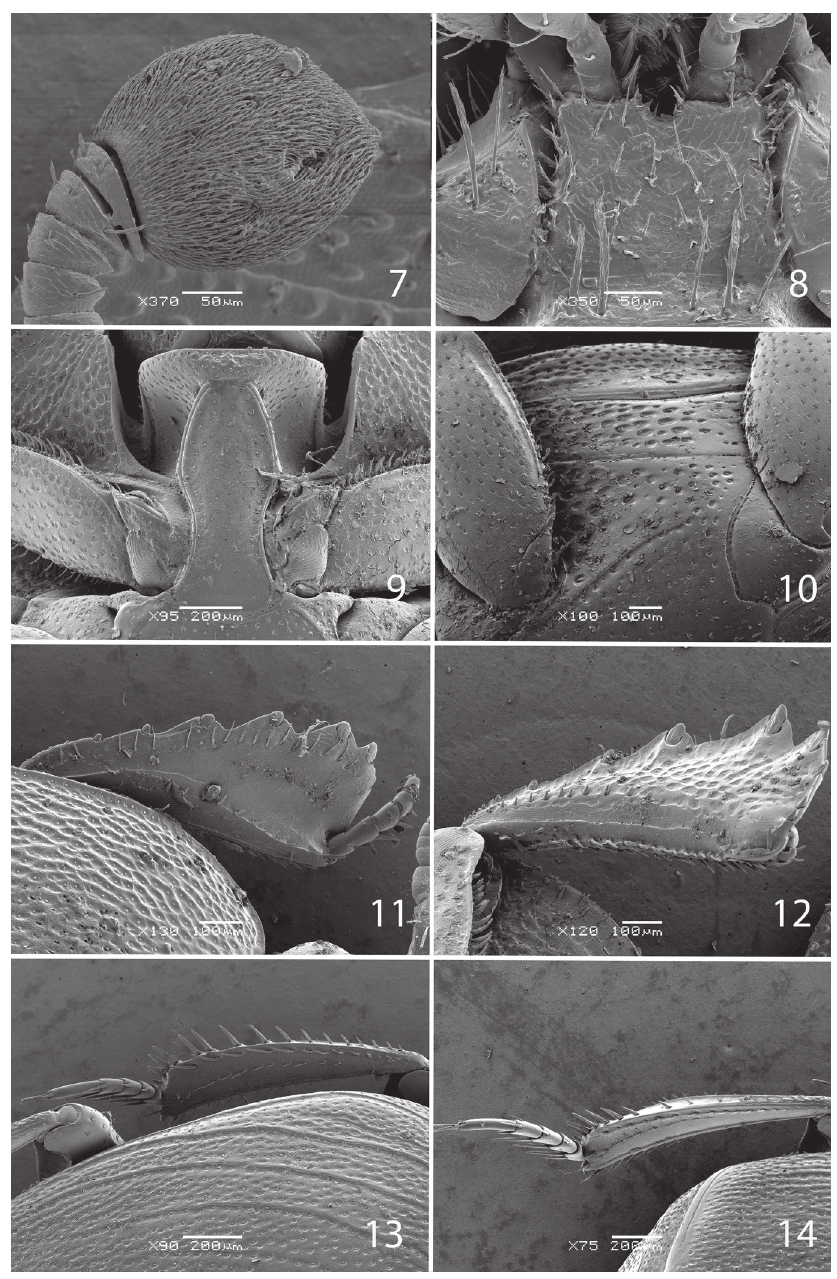
Figures 7–14. 7 Eremosaprinus warneri sp. n., left antennal club, ventral view. 8 Eremosaprinus warneri sp. n., mentum, ventral view 9 Eremosaprinus warneri sp. n., prosternum 10 Eremosaprinus warneri sp. n., lateral disk of metaventrite + metepisternum 11 Eremosaprinus warneri sp. n., protibia, dorsal view 12 ditto, ventral view 13 Eremosaprinus warneri sp. n., mesotibia, dorsal view 14 Eremosaprinus warneri sp. n., metati- bia, dorsal